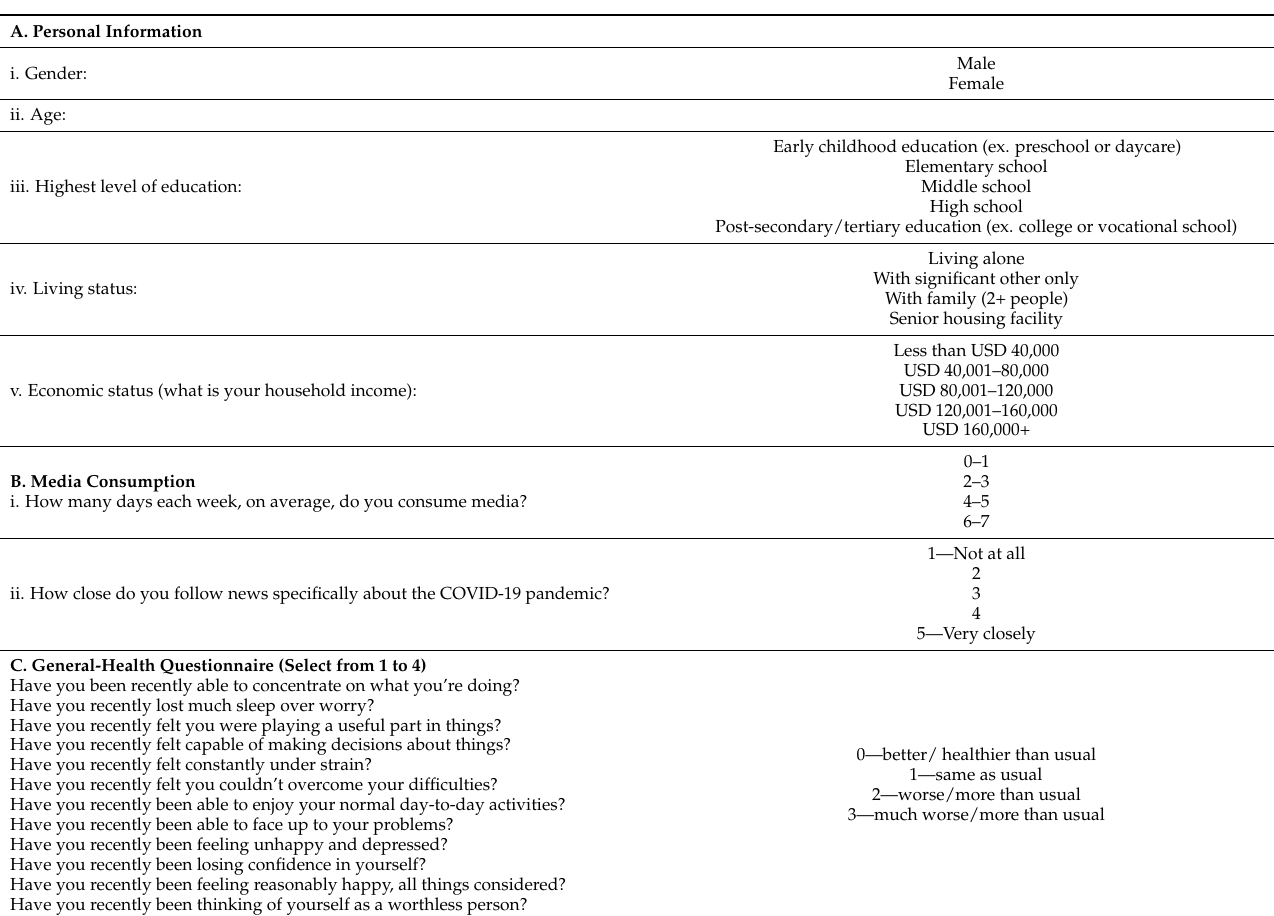
Table A1. Survey of the impact of media on the